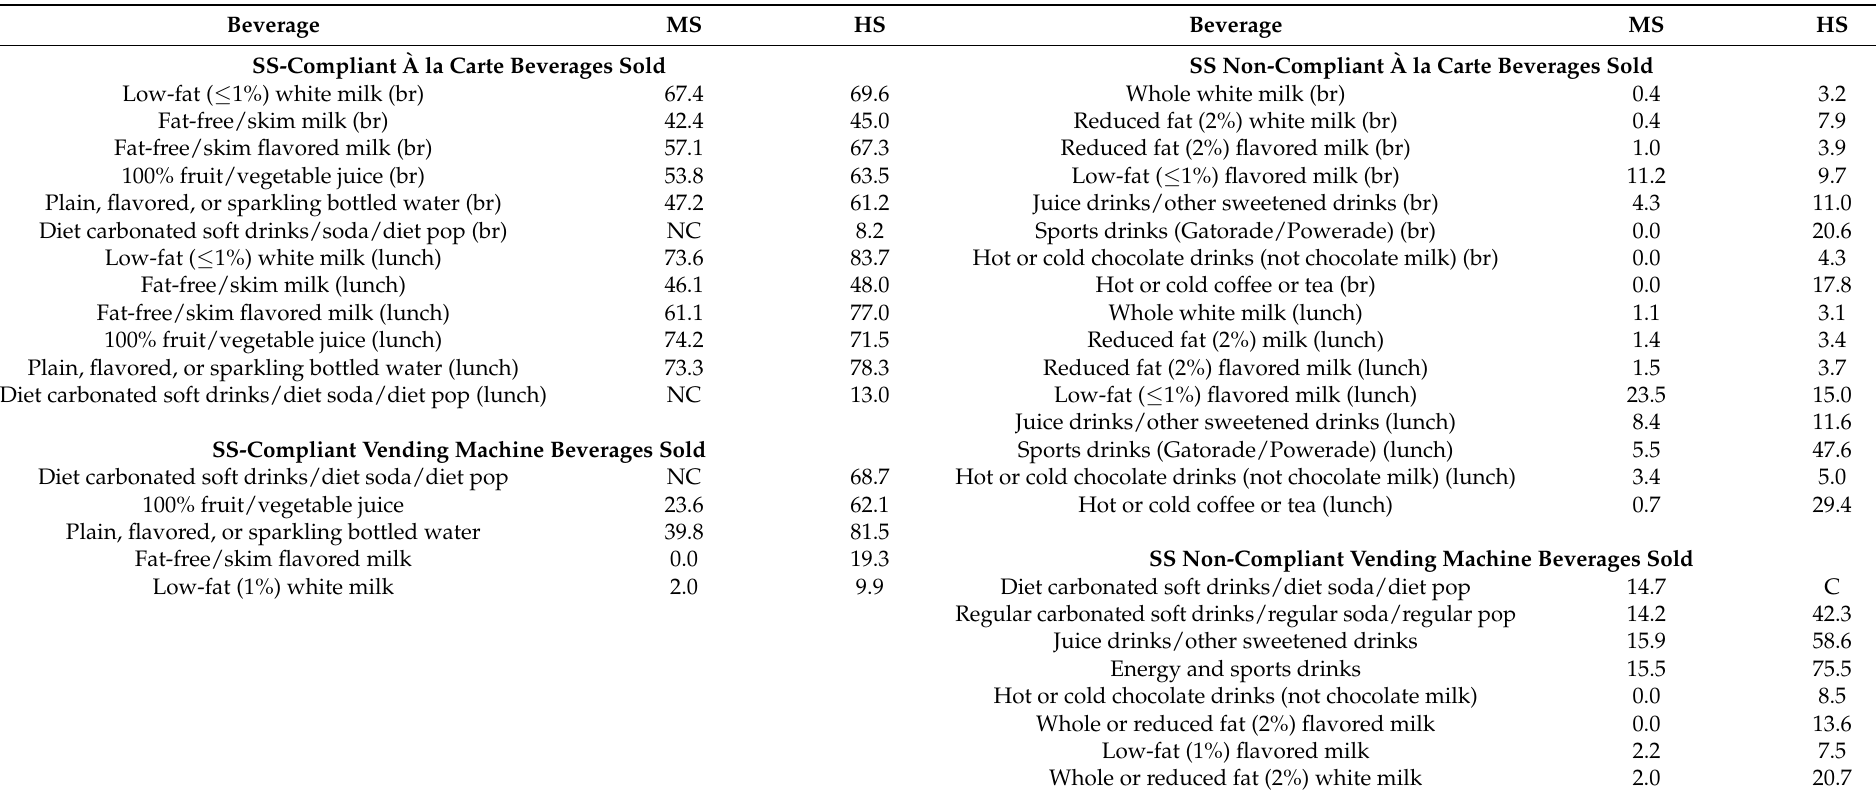
Table 2. Weighted Percentage of Students with Access to Given Smart Snacks-Compliant and Non-Compliant Beverages Sold by Location of Sale and School Level. Beverage MS